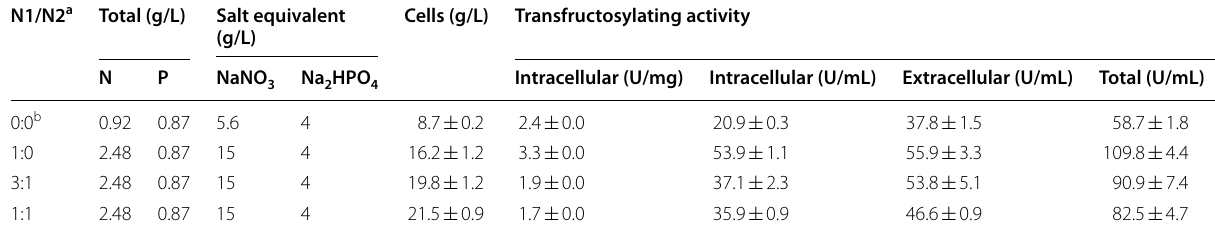
Table 1 Transfructosylating activities of intracellular, extracellular, and total enzymes after 72 h of shake-flask cultivation with two exogenous nitrogen sources at different